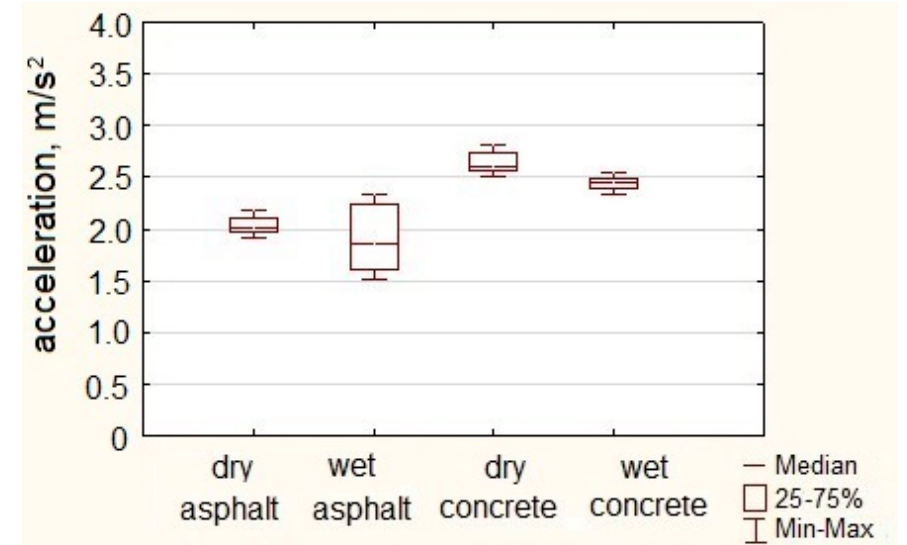
Figure 7. Longitudinal acceleration of urban buses during acceleration. During sudden acceleration maneuvers of an urban bus on an asphalt dry surface, the average maximum acceleration value was 2.03 m/s 2 . The maximum acceleration value achieved in maneuvers on dry asphalt pavement was 2.18 m/s 2 .